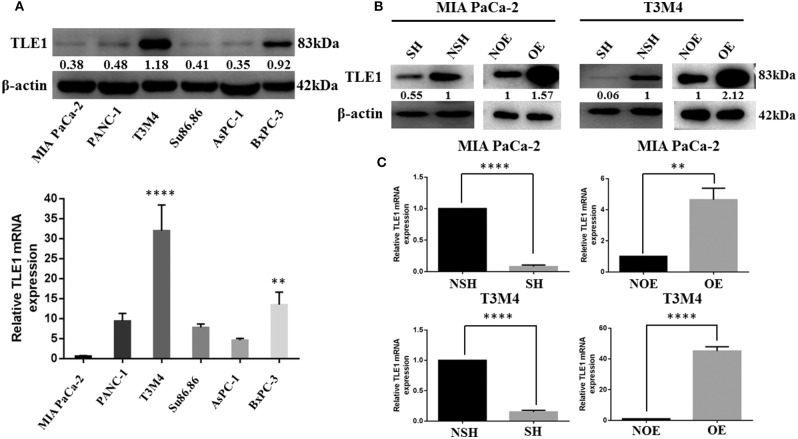
Selection of MIA PaCa-2 and T3M4 cell lines as the experimental models and establishment of cell lines by transient transfection for TLE1 overexpression or TLE1 knockdown. (A) TLE1 protein and mRNA expression in six PDAC cell lines. (B,C) The efficacies of TLE1 overexpression and TLE1 knockdown were confirmed by western blot and RT-PCR analyses. Data are presented as mean ± SD. **P < 0.01, ****P < 0.0001, by Student's t-test. PDAC, pancreatic ductal adenocarcinoma; TLE1, transducin-like enhancer of split-1; OE, TLE1 overexpression; NOE, negative control for TLE1 overexpression; SH, TLE1 knockdown; NSH, scrambled control (n = 3).